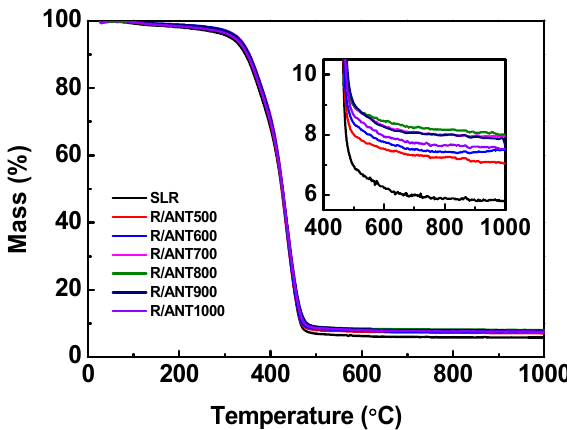
Figure 11. The thermal stability analysis for 3D printed samples of neat SLR and SLR/nanofillers 3D printed samples. The inset shows the enlarged view of the curves between 400 °C and 1000 °C to understand the final residual char values.